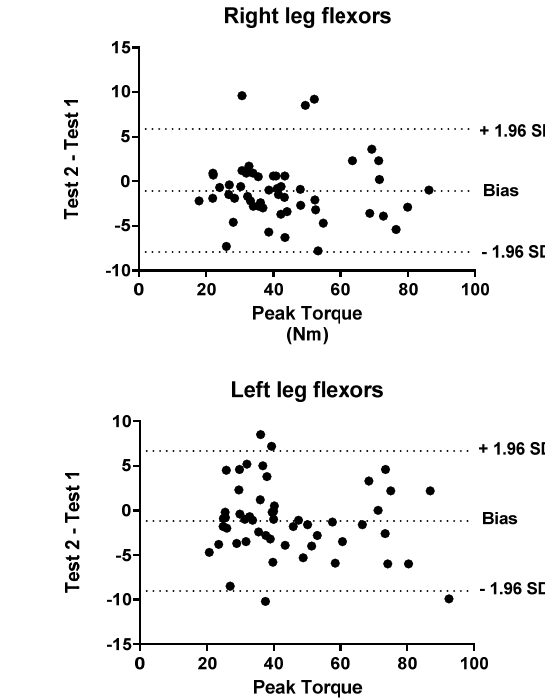
Table 3. Absolute and relative test-retest reliability of the Peak torque and Work.